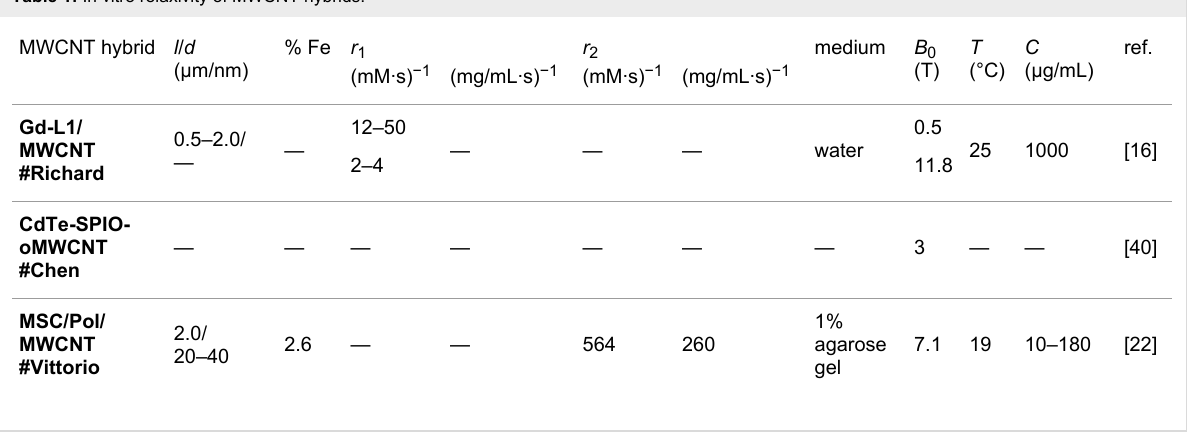
MWCNT hybrid l / d